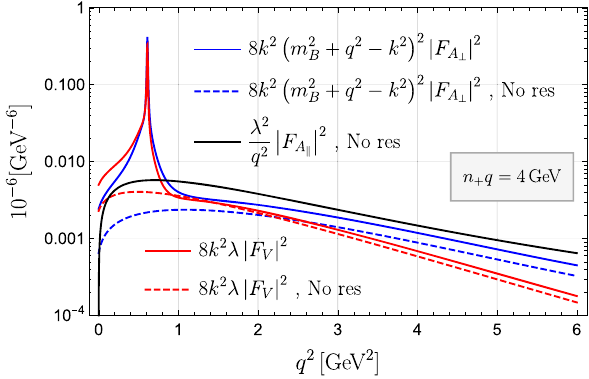
Fig. 6 Contribution of the form factors to the rate in (2.10) including kinematicfactors.For F V and F A ⊥ ,weshowtheQCDFresults(labelled “No res”) and the full result including